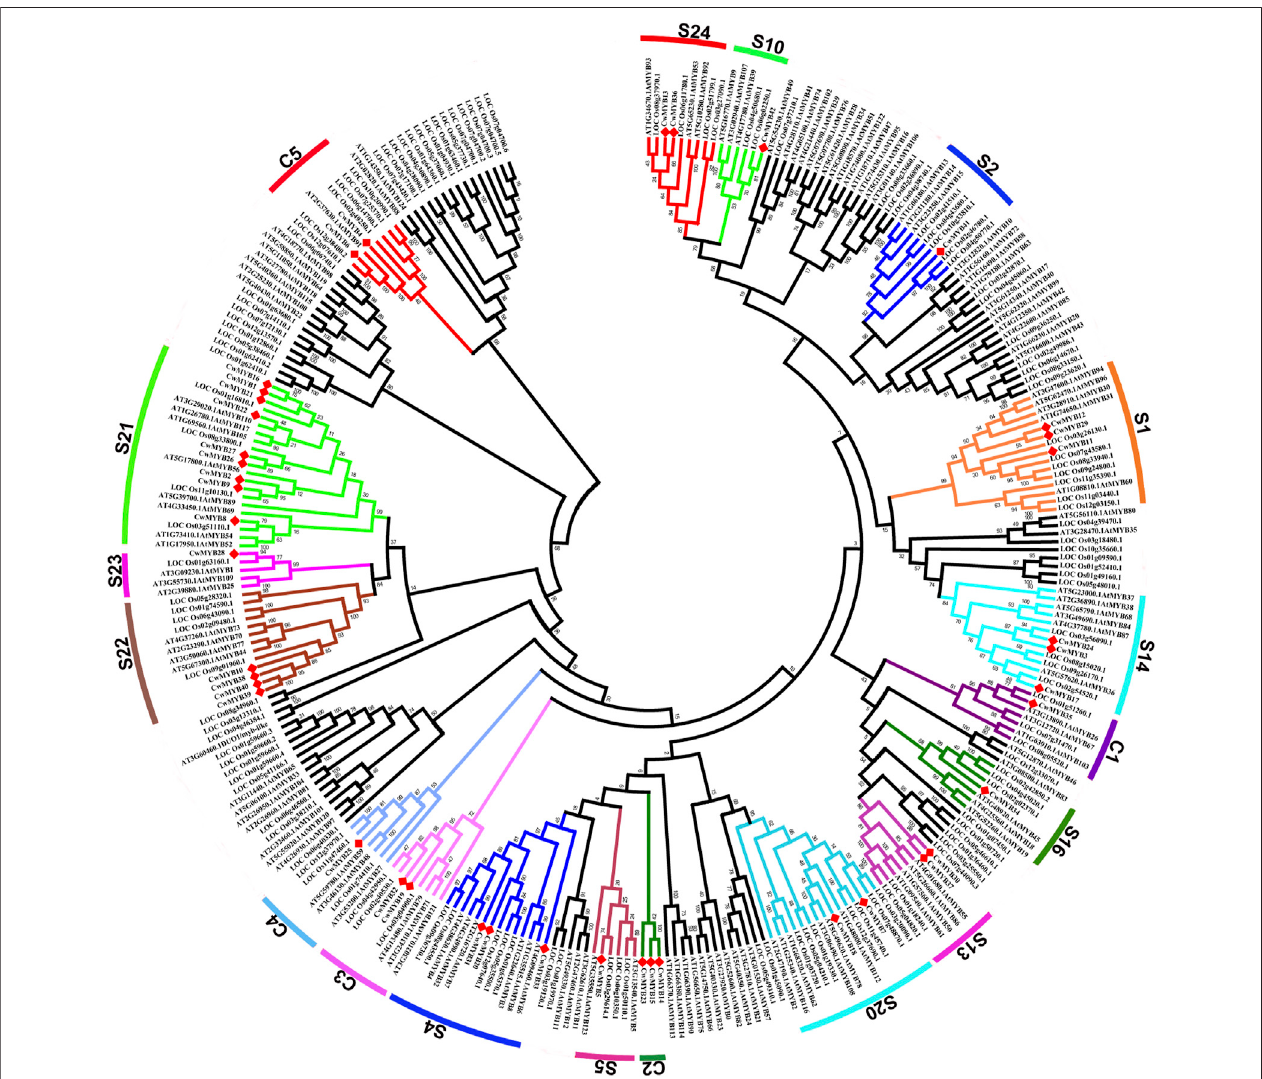
FIGURE 5 | Phylogenetic tree of R2R3-MYBs in C. wenyujin , Arabidopsis thaliana , and Oryza sativa . The sequences contain 42 CwR2R3-MYBs in C. wenyujin , 126 AtR2R3-MYBs in Arabidopsis, and 130 OsR2R3-MYBs in rice. Forty-two full length CwMYB1-42 were divided into 13 subgroups (S) and 5 classes (C1-C5). The picture was generated using MEGA 7 software coupled with Neighbor-Joining method with a bootstrap of 1,000 replicates.